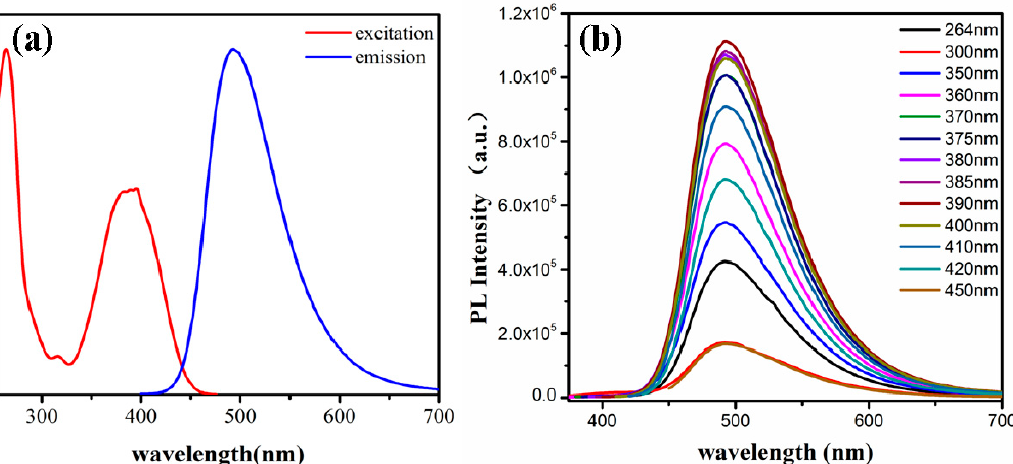
Figure 2. The optical properties of CDs. ( a ) The normalized PL excitation and emission spectra of CDs; ( b ) PL spectra of CDs at different excitation wavelengths.